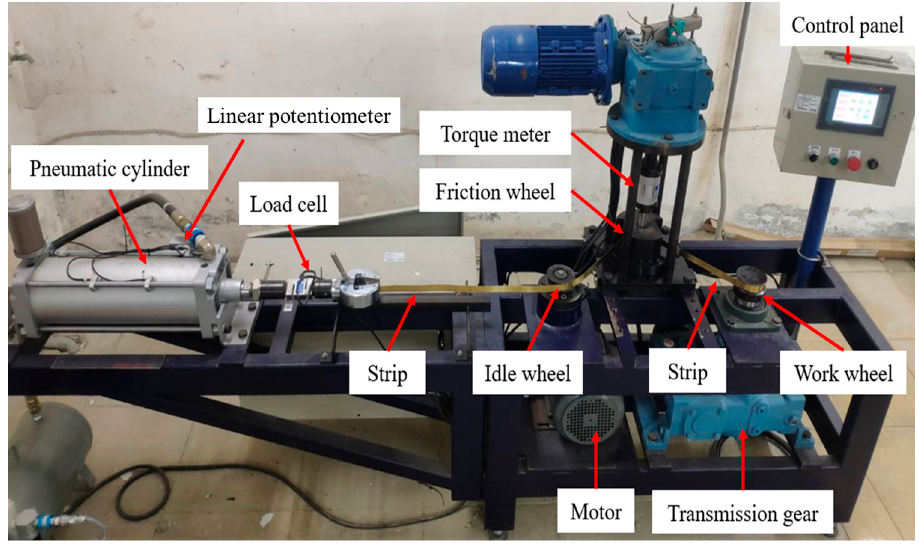
Figure 2. Appearance of self-developed friction test machine.